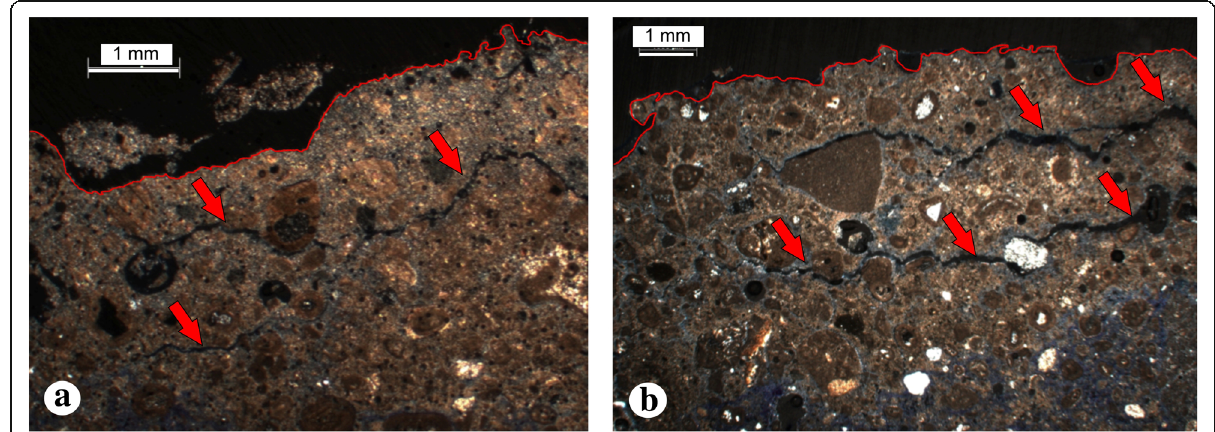
Fig. 9 Surface parallel cracks (arrows) observed in mortar specimens. a Mortar A. b Mortar C (see sample description in Table 1). The boundaries of split surfaces are marked by red lines